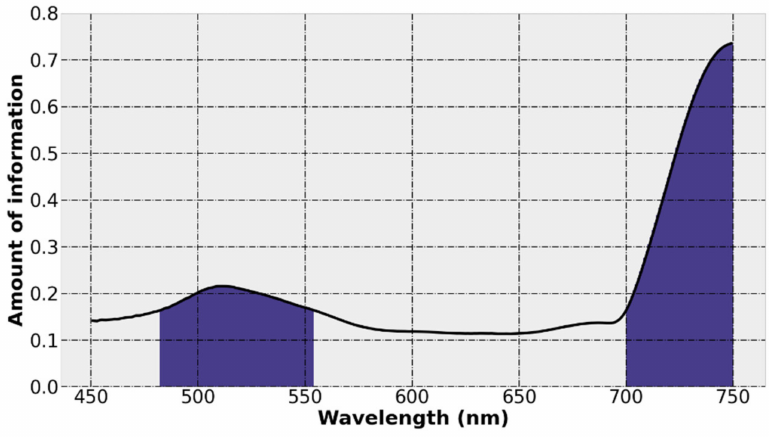
Figure 10. LBI calculation